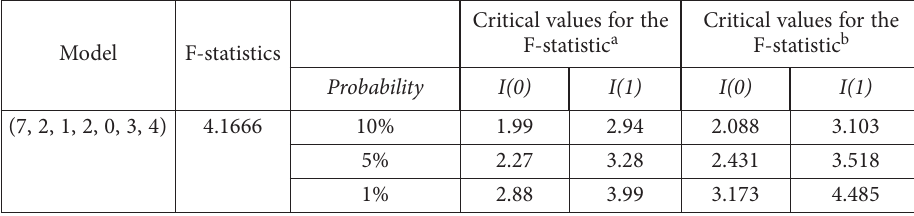
Critical values for the F-statistic